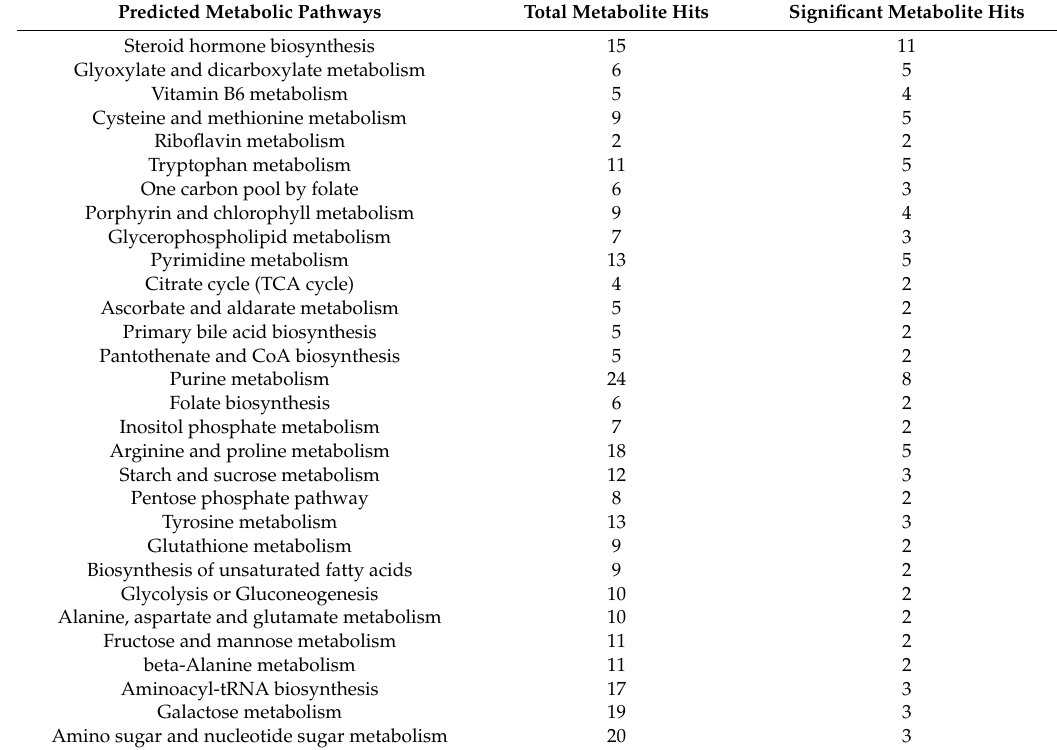
Table 1. Predicted pathway activity profiles based on the pathway analysis of LC-MS data from rat urine samples of 4NQO exposed rats fed control diet, or diet supplemented with 5% or 10% BRB as determined using Mummichog in MetaboAnalyst. Significant hits represent di ff erentially expressed metabolites in the predicted pathway between rat groups. Predicted Metabolic Pathways Total Metabolite Hits Significant Metabolite Hits Steroid hormone